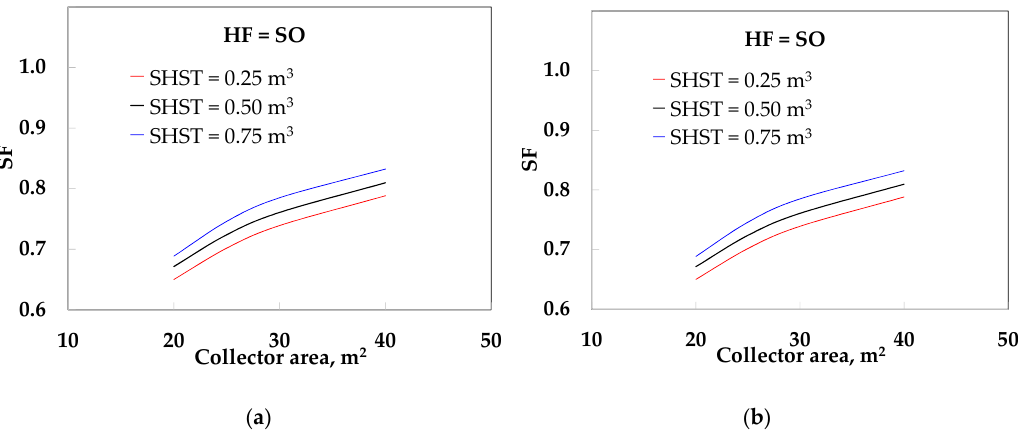
Figure 13. Solar fraction as a function of parabolic trough collector (PTC) collector area for sensible heat storage tank (SHST) (configuration 1) using ( a ) SO and ( b ) water.